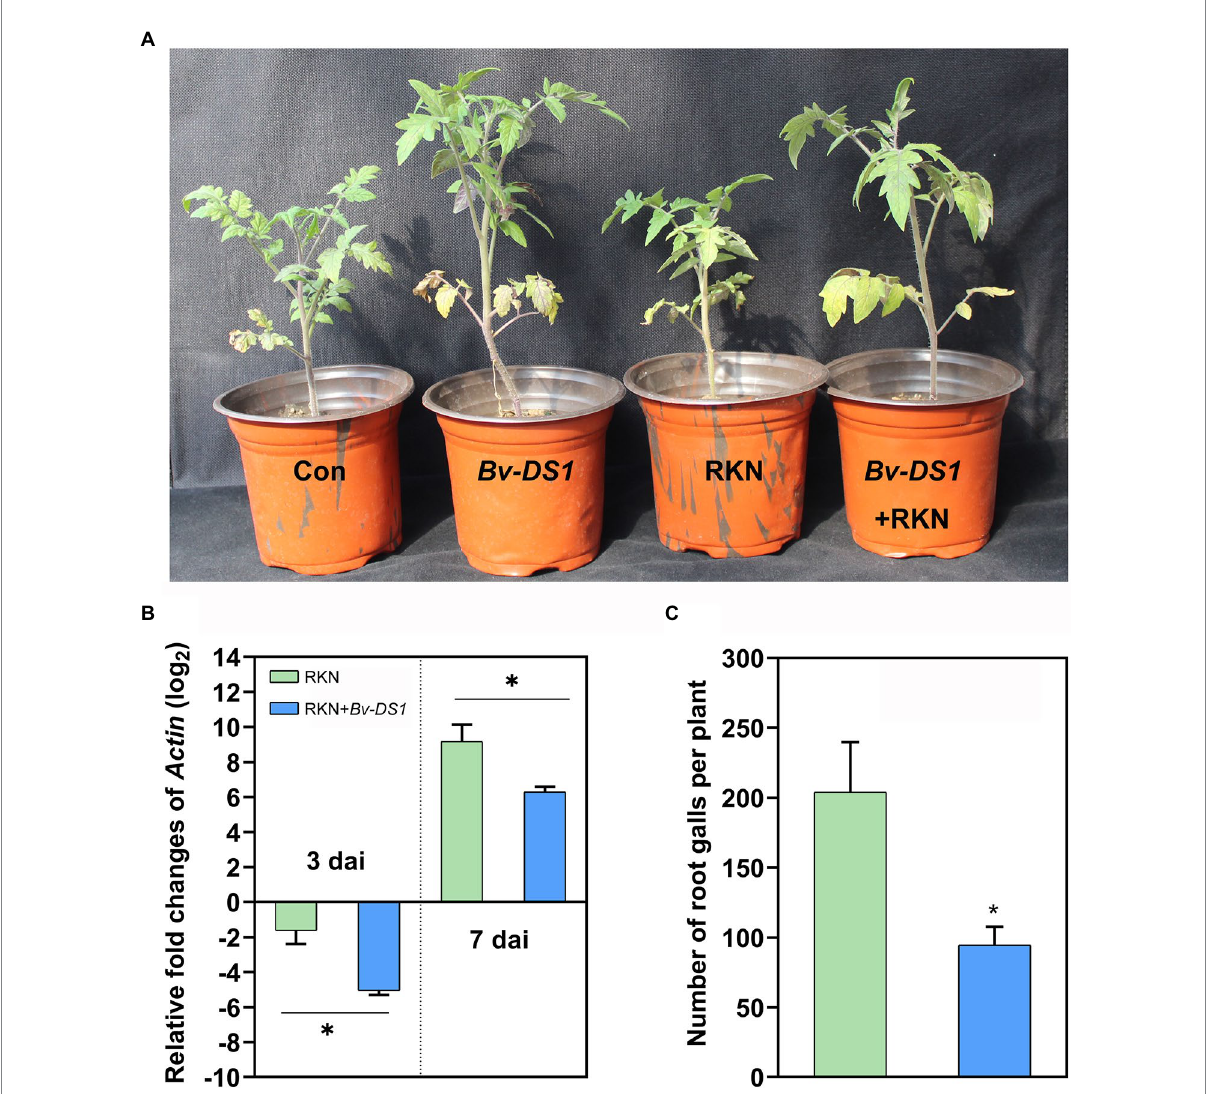
FIGURE 3 The control efficacy of Bacillus velezensis YS-AT-DS1 ( Bv-DS1 ) against M. incognita in pots. (A) Plant growth promotion was observed in the Bv- DS1 -pre-inoculated tomato plants on the 35th day after inoculation (dai) with M. incognita . (B) The relative expression folds of the actin gene from M. incognita were evaluated inside the roots of Bv-DS1 -pre-inoculated or non-inoculated tomato plants at 3 and 7 dai. Each value is presented as mean ± SE of three biological replicates for all three plant roots. Asterisks indicate significant differences between treatments ( p < 0.05) according to Student’s t test. (C) The number of galls was counted in roots of Bv-DS1 -pre-inoculated or non-inoculated tomato plants at 35 dai. Data are presented as mean ± SE of eight plants for each treatment. Asterisk indicates statistically significant differences between treatments ( p < 0.05) according to Student’s t